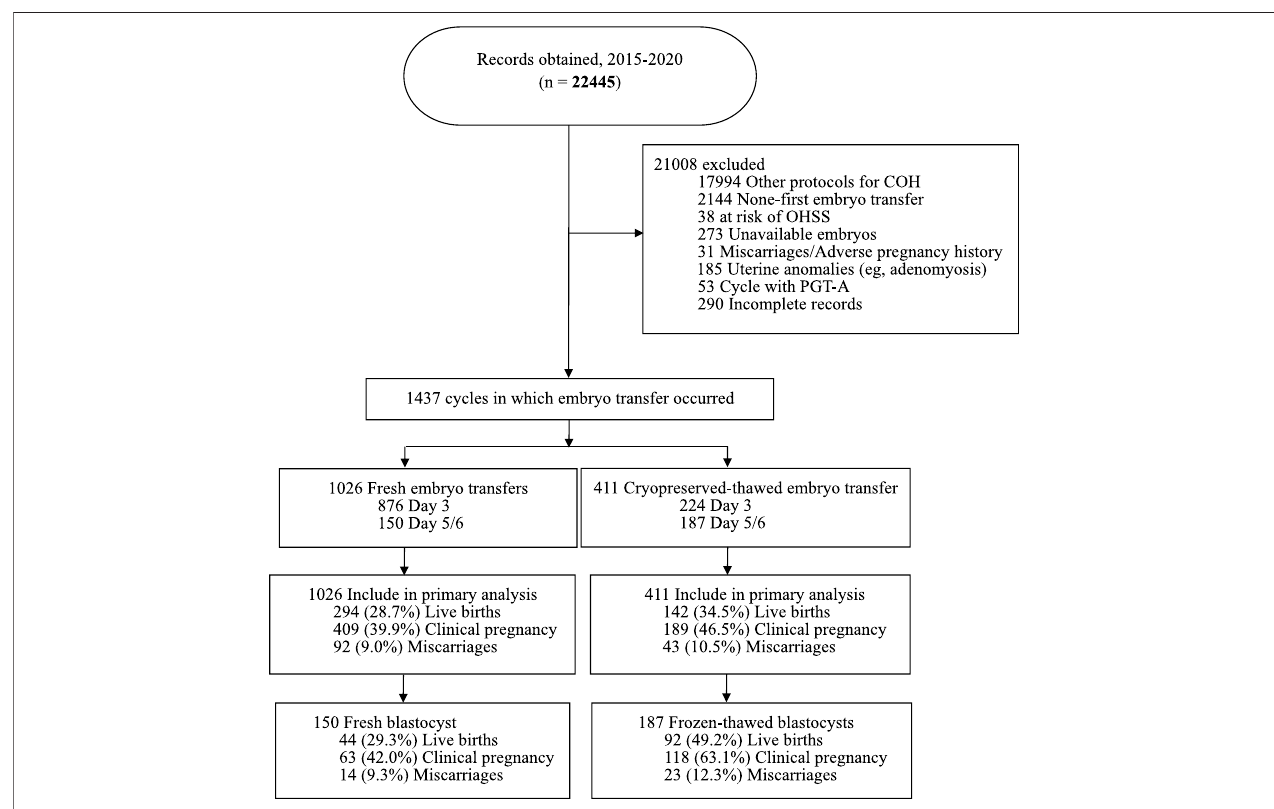
FIGURE 1 | Outline of the selection process, transfer cycle type, embryo stage at transfer and outcomes of embryo transfer cycles included in this study.